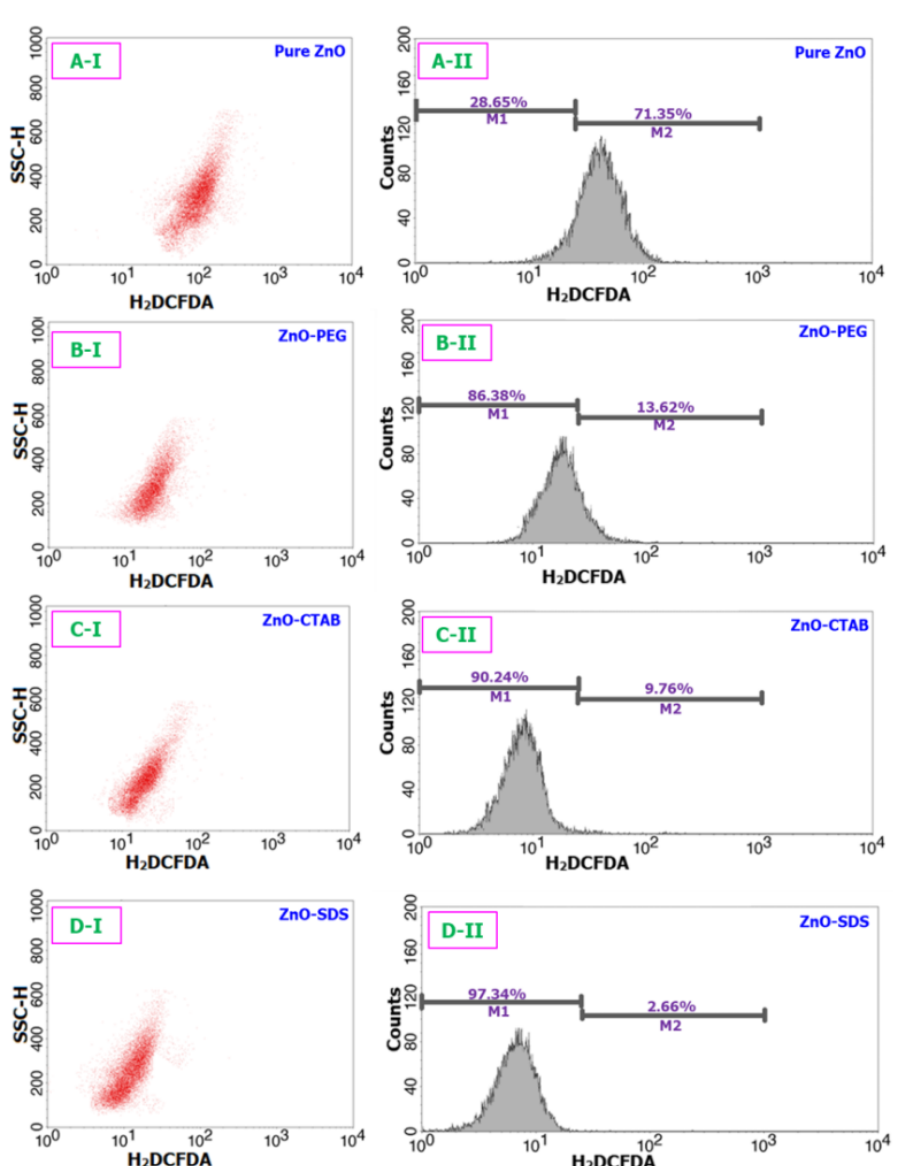
Figure 7. Assay of ROS to understand the oxidative stress potentials of all four ZnO samples over a 24 h period. ( A-I ) and ( A-II ) stands for the flow cytometric cell differentiation and fluorescence intensity (respectively) of pure ZnO sample. Likewise, ( B(I,II)–D(I,II) ) correspond to ZnO-PEG, C-ZnO-CTAB, and D-ZnO-SDS samples respectively.